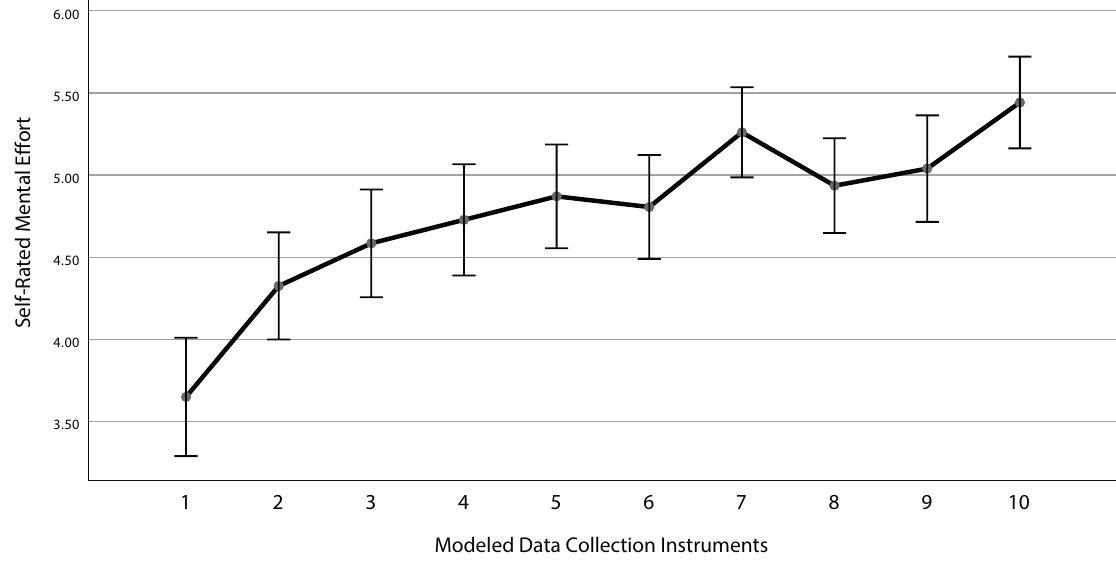
Figure 4. Mean ± 95% confidence interval of the mental effort after modeling data collection instruments.